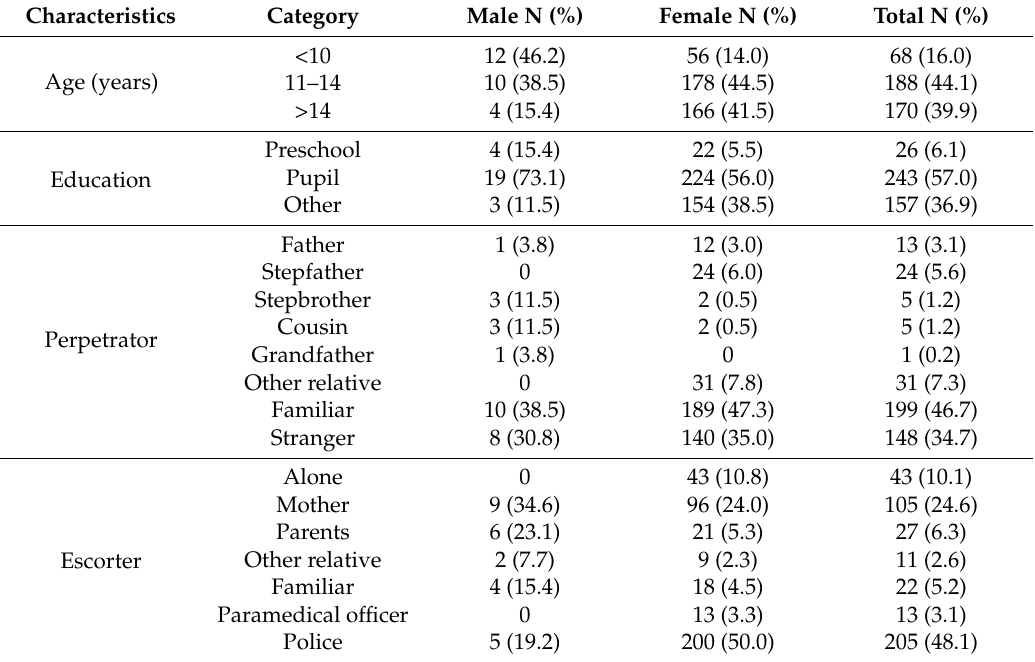
Table 1. Characteristics of the victims (n = 426).